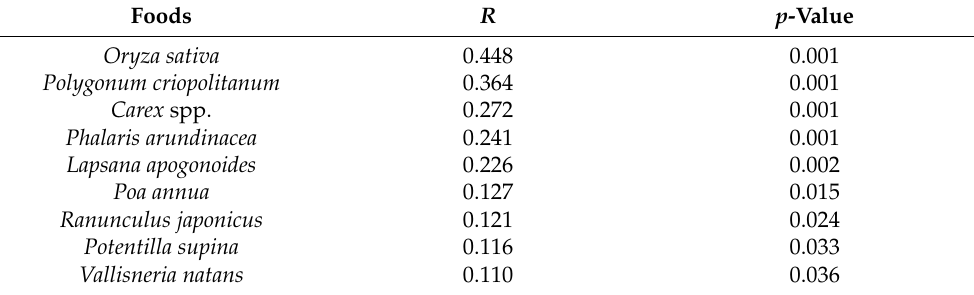
Table 2. Foods related to the composition of the intestinal bacteria of hooded cranes according to Mantel test.